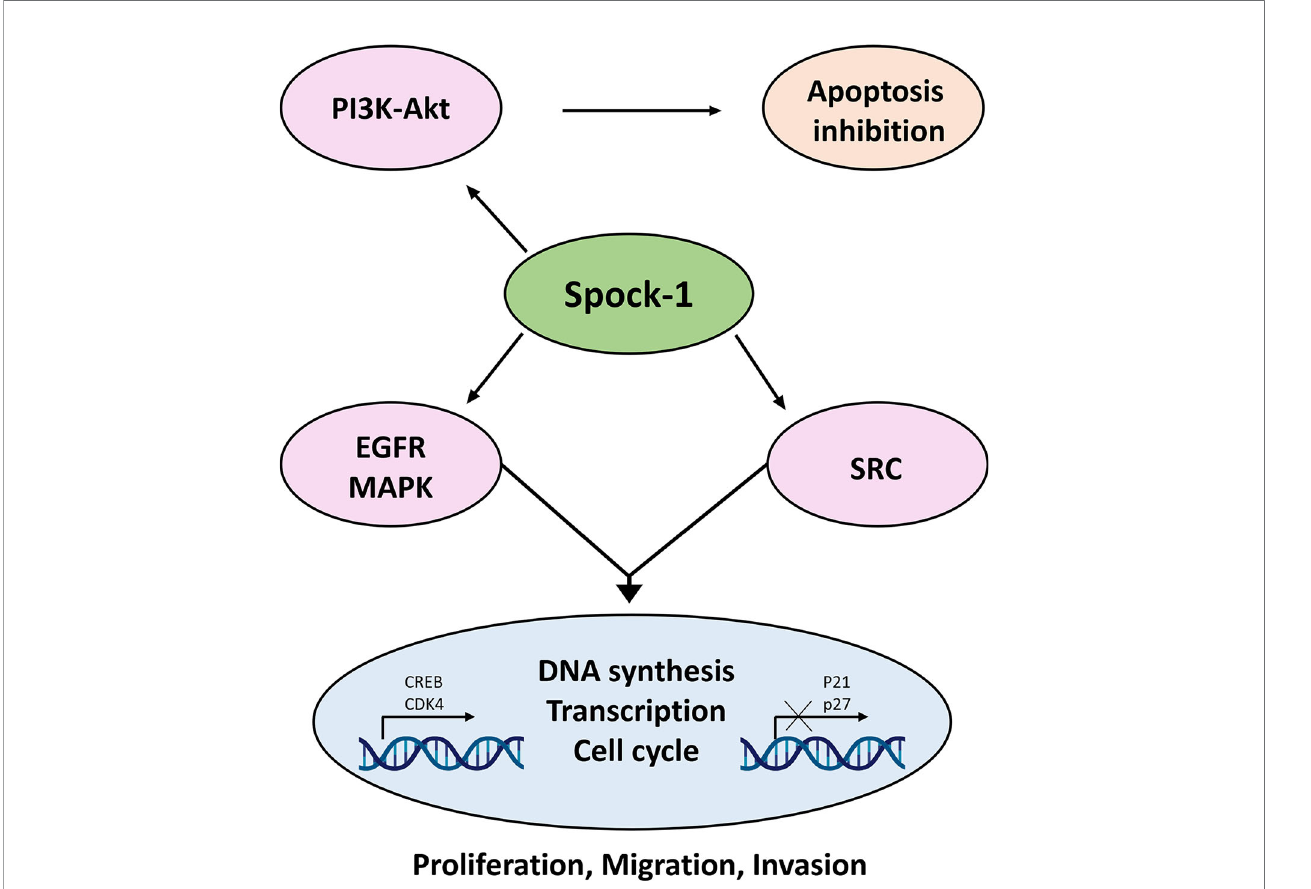
FIGURE 14 | Action of SPOCK1 in hepatoma cell lines. In harmony with previous results, Spock-1 stimulates the Akt-mTOR pathway. Akt activation results in apoptosis inhibition. The mitochondrial localization of the proteoglycan may interfere in other ways as well with the apoptotic activity, which needs further evaluation. SPOCK1 silencing resulted in the downregulation of the EGFR tyrosine kinase receptor and members of the Sarc tyrosine kinase family, indicating the stimulatory potential of the proteoglycan on the signaling activity, partly through the MAPK pathway. Furthermore, SPOCK1 inhibition pointed to a decrease of two nuclear proteins CREB and CDK4; the former is a multivalent transcription factor with strong oncogenic potential, and the latter is the stimulator of cell cycle. Both nuclear proteins can be upregulated via MAPK signaling. Furthermore, CREB establishes interaction with several nuclear factors, facilitates DNA synthesis, and regulates chromatin function as well. Its action is in a good agreement with the effect of SPOCK1 on DNA synthesis, cell migration, and invasion